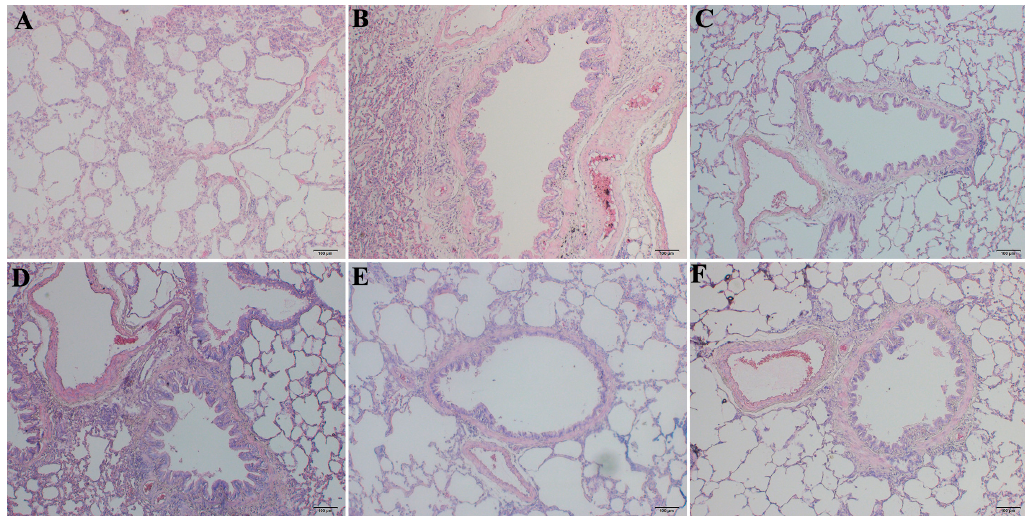
Figure 2. The H & E of the lung tissues in rats (Bar = 100 μ m). ( A ) normal group; ( B ) model group; ( C ) PAG group; ( D – F ) are RRL groups treated with 125, 250 and 500 mg/kg, respectively.